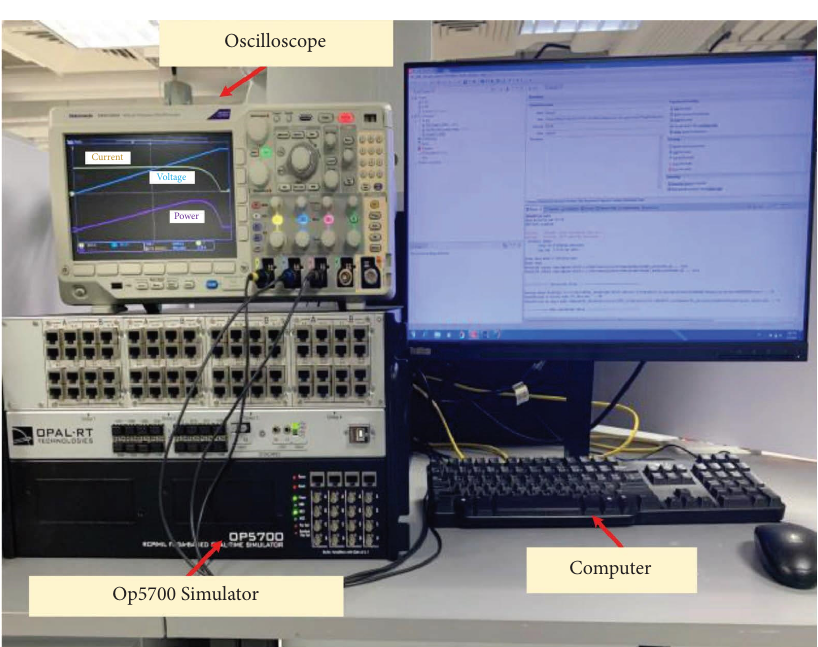
Figure 8: Te RTLAB platform-based real-time hardware-in-the-loop experiment.